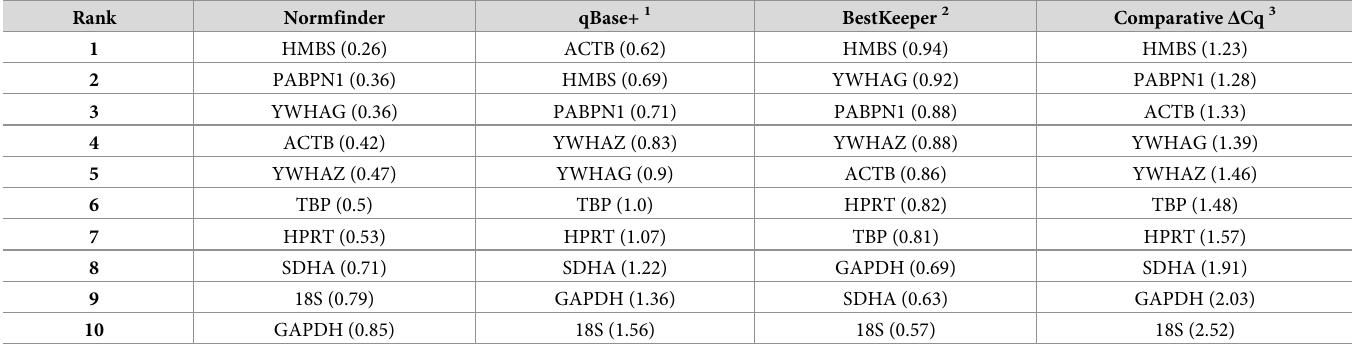
Table 4. Reference gene ranks.